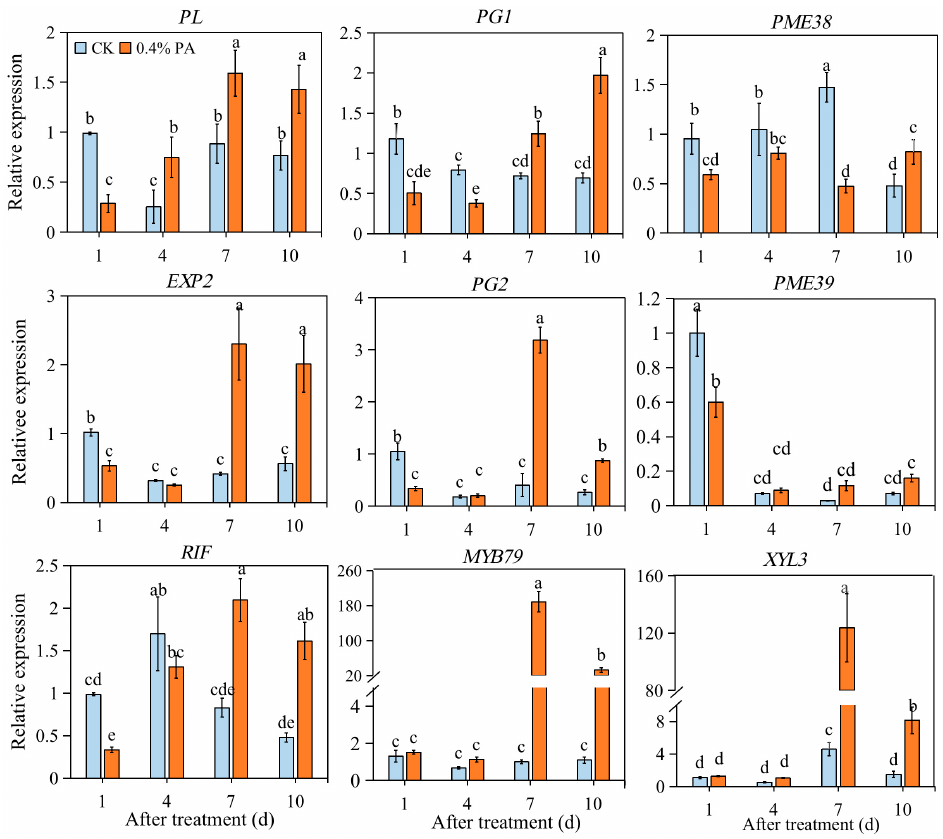
Figure 5. Relative transcript levels of cell-wall-related gene expression under 0.4% PA treatment. PL : pectate lyases; PG : polygalacturonase; PME : pectin methylesterase; RIF : ripening inducing fac-